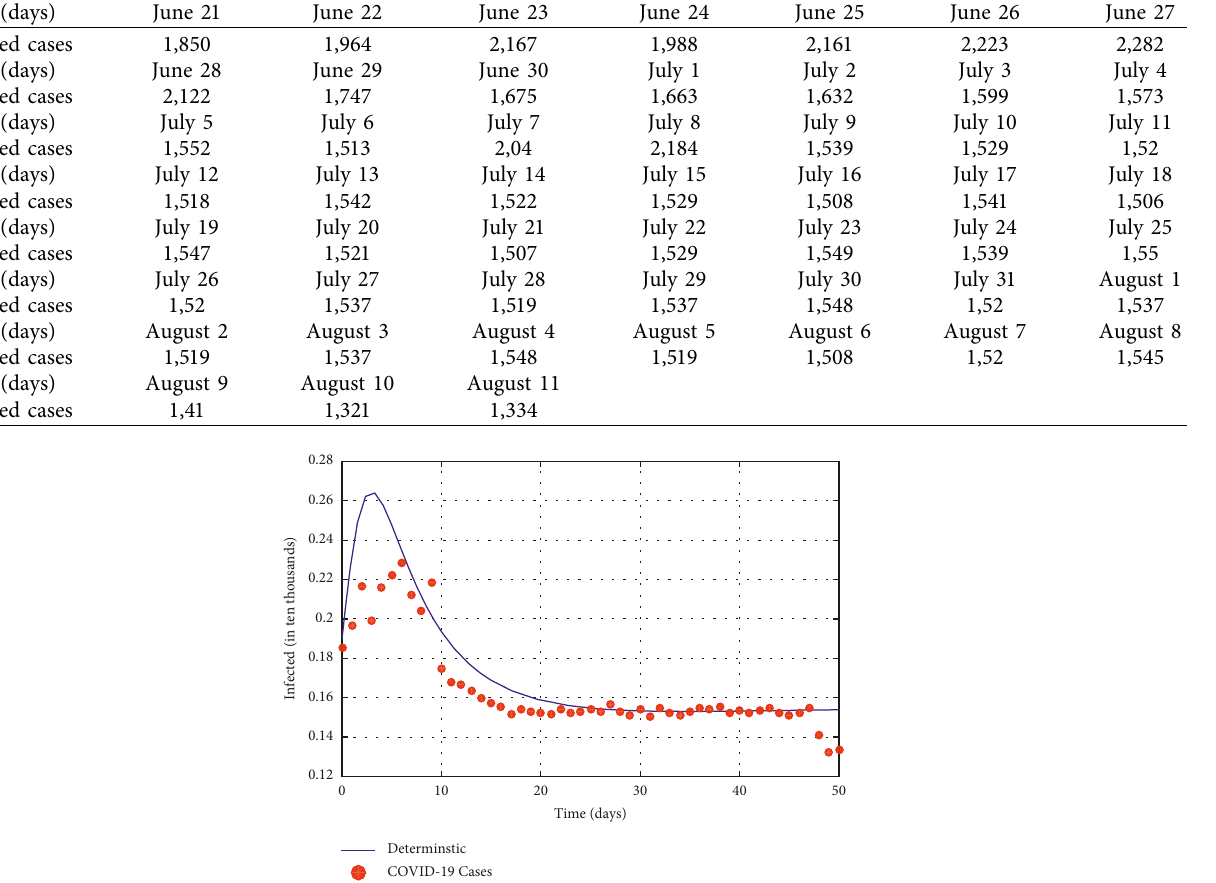
Figure 6: The fitted curve of DDEs model (2) and the confirmed COVID-19 cases in the UAE from June 22, 2021 to August 11, 2021. The � 1 . 99854, 􏽢 β � 1 . 9813, 􏽢 β � 0 . 219092, 􏽢 κ � 0 . 01099, and 􏽢 r � 0 . 047. estimated parameters are 􏽢 β 2 5 6